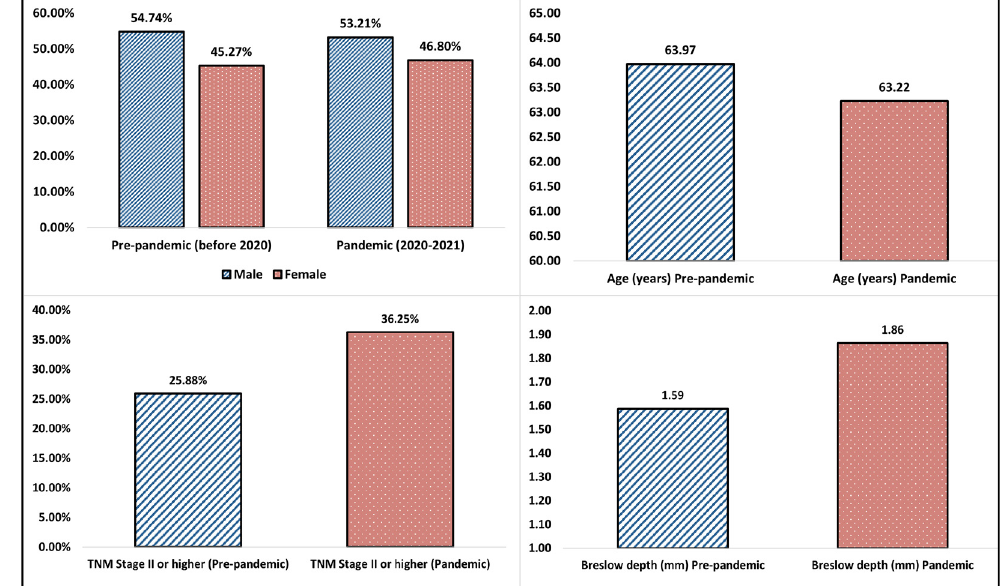
Figure 2. Summary of findings.